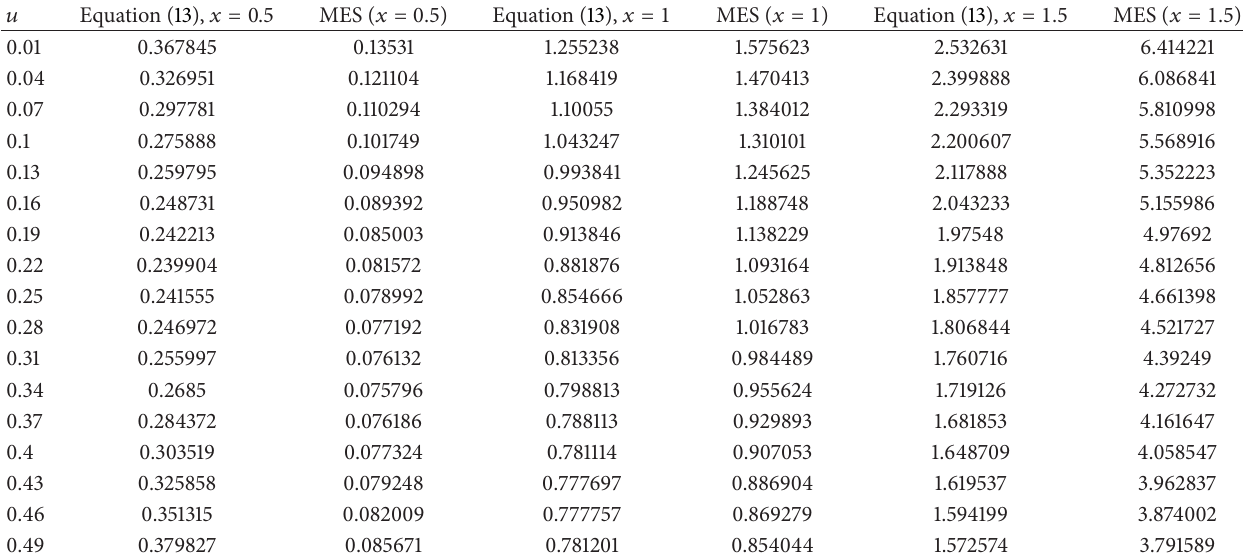
Table 3: Equations (13) and (16): 𝐷 1/5 𝑥 2 = 1.8 ∗ 𝑢 4/5 ∗ (𝑥 − 𝑢) .